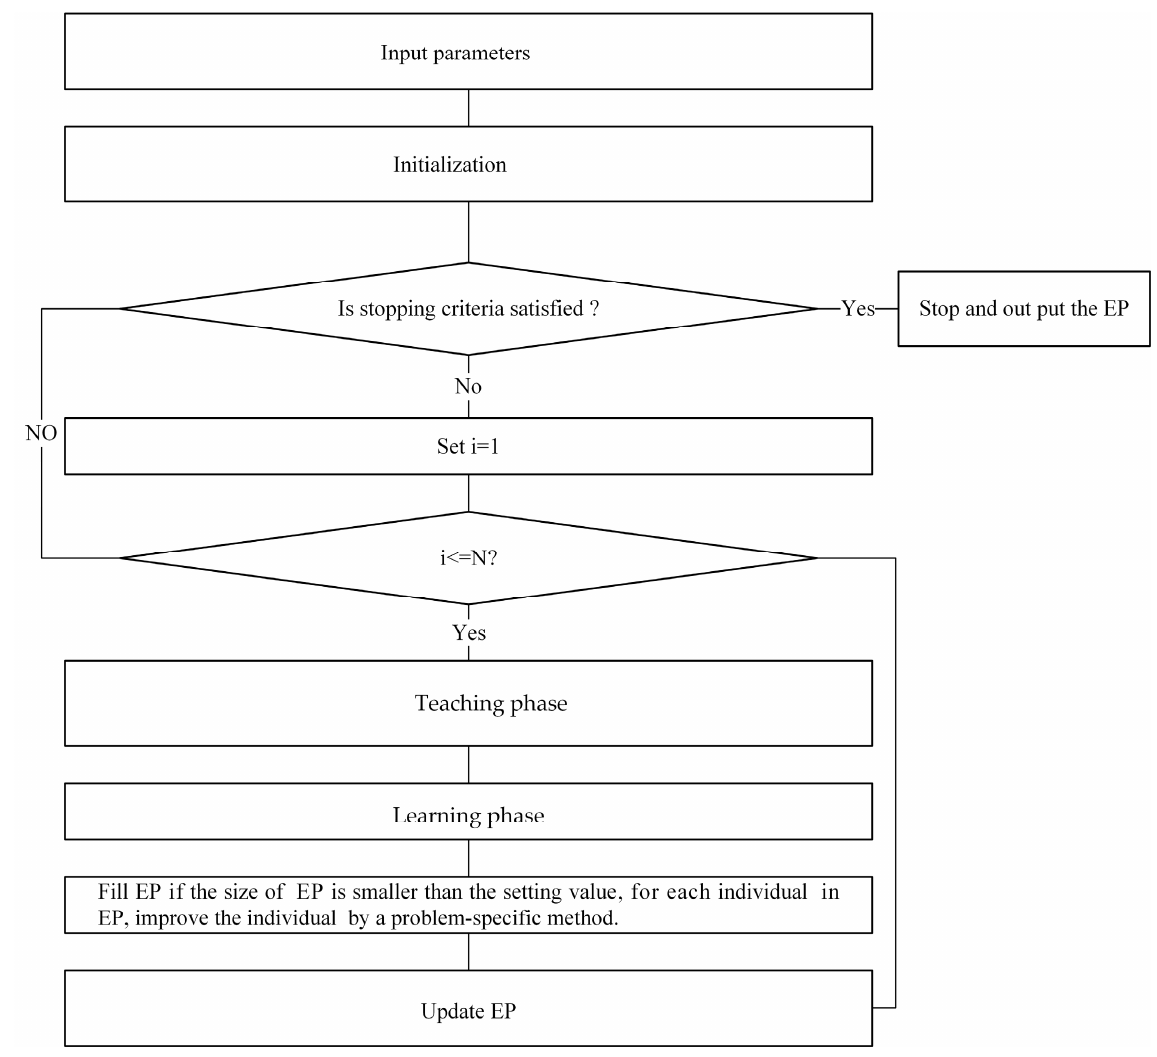
Figure 3. The flow chart of Multi-Objective Evolutionary Algorithm based on Decomposition and Teaching–Learning-Based Optimization (MOEA/DTL). Algorithm 1 MOEA/DTL